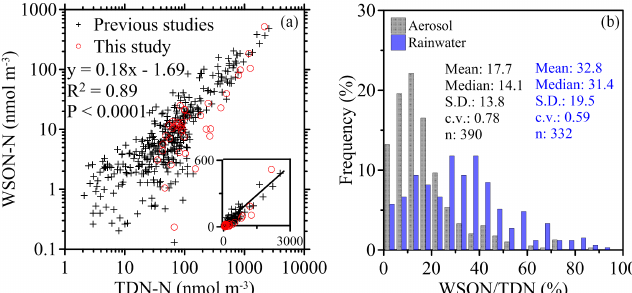
Figure 9. (a) Scatter plot of published aerosol WSON and TDN concentrations from around the world (red circles for this study, black crosses from Lesworth et al., 2010; Chen et al., 2007; Mace et al., 2003a; Miyazaki et al., 2011; Shi et al., 2010a; Srinivas et al., 2011; Zamora et al., 2011; and Violaki et al., 2015). (b) Frequency histograms for percentage WSON in aerosol TDN (grey bars, data from a ) and in rainwater (blue bars, data from Cornell, 2011; Zhang et al., 2012; Altieri et al., 2012; Cui et al., 2014; Chen et al., 2015; and Yan and Kim, 2015).